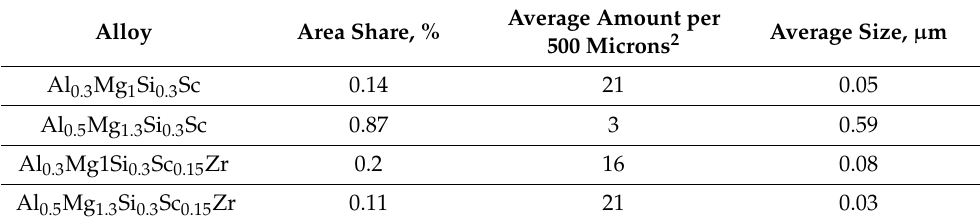
Table 2. Size and amount of dispersoids in the investigated alloys.